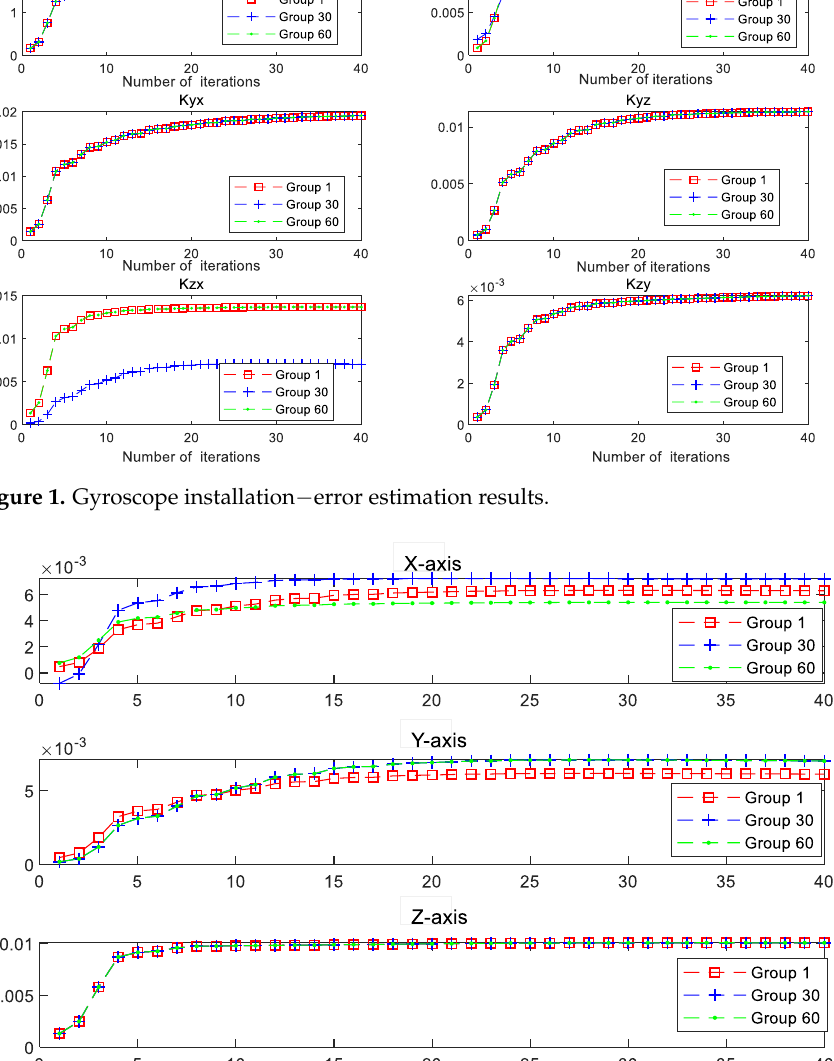
Figure 3. Gyroscope zero − bias estimation results.